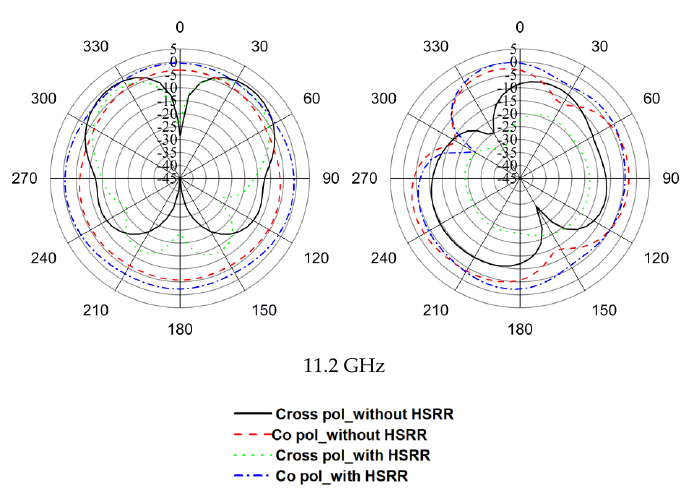
Figure 13. 2D radiation pattern of the UWB antenna without and with HSRR.